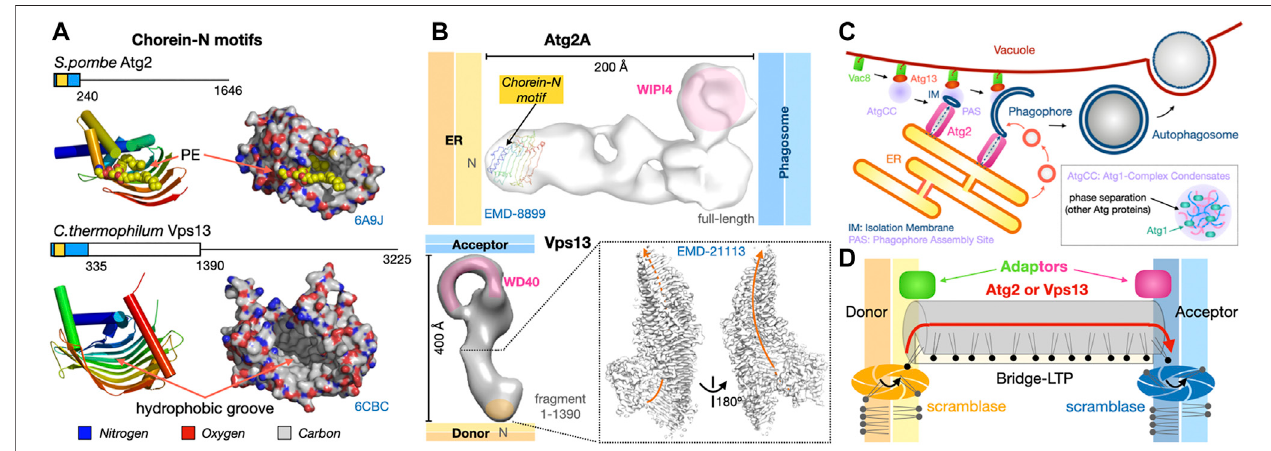
FIGURE 9 | Dual tethers/LTPs Vps13 and Atg2 form bridges to transfer lipids in bulk at membrane contact sites. (A) . Schematic structure of the Atg2 and Vps13 proteins from S. pombe and yeast are shown together with the crystal structures of the N-terminal fragments of S. pombe Atg2 (21-246) (PDB 6A9J) and C. thermophilum Vps13 (1 – 335) (PDB 6CBC) containing the Chorein-N motifs ( ∼ 100 residues boxed in yellow). Areas boxed in blue correspond to crystallized fragments. (B) NS-EM density map (30 Å resolution EMD-8899) of full-length (1-1938) human Atg2A bound to WIPI4. NS-EM density map (30 Å resolution) of full-length (1- 3144)yeastVps13andcryo-EMmap(3.8 ÅresolutionEMD-21113)oftheN-terminalfragment(1-1390)ofVps13fromC. thermophilum .Thecryo-EMmapof Ct -Vps13 revealsthepresenceofacentralgroovesuitedforthetransferofPLs(orangearrow).TherelativepositionoccupiedbythecrystallizedfragmentcontainingtheChorein-N motifisshown inhAtg2A.Membranes and proteins are drawnto scale. TheWIPI adaptor protein bound to Atg2A or WD40-like domain ofVps13 arehighlighted inpink. (C) Bulk autophagy in yeast localizes at the ER-vacuole interface. Vacuolar protein 8 (Vac8) and Atg13 localize the Atg1-Complex Condensates near the membrane where Atg1 activation by phosphorylation triggers the formation of an isolation membrane (IM) at the phagophore assembly site (PAS). The LTP-bridge Atg2 fuels phagophoreexpansionbychannelingERPLsinsynergywithvesicularaccretion.Maturedautophagosomessubsequentlyfusewiththevacuoleandtheircontentisthen degraded/recycled. (D) “ Lipidsink ” modelforthebulktransferoflipidsbyAtg2andVps13.ForAtg2,scramblasesinthedonorandacceptormembranesdriveexchange by re-equilibrating lipid concentrations between lea fl ets.